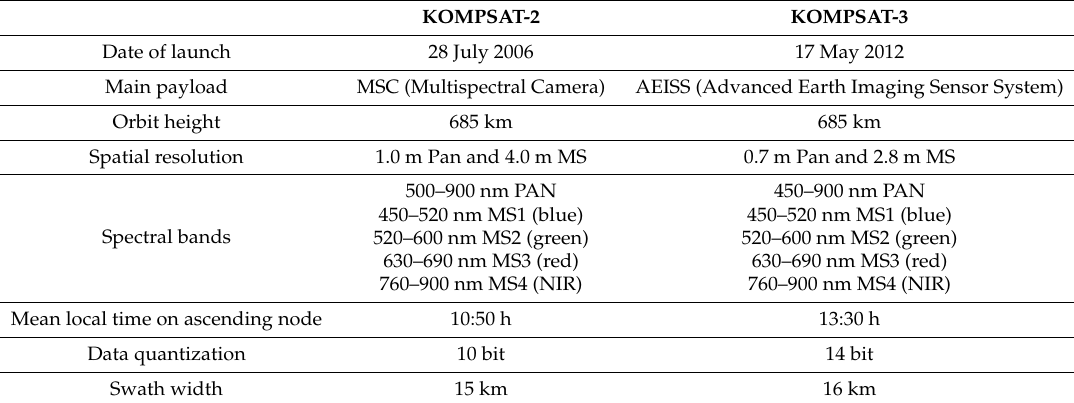
Table 1. Specifications of the Korea Multi-Purpose Satelllite-2 (KOMPSAT-2) and Korea